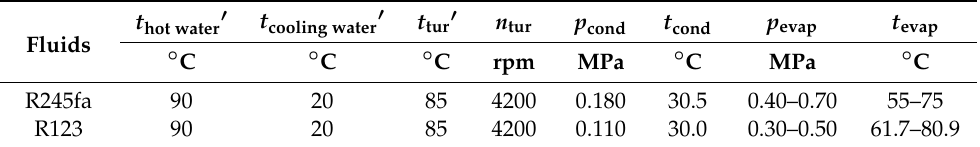
Table 3. Parameters range in